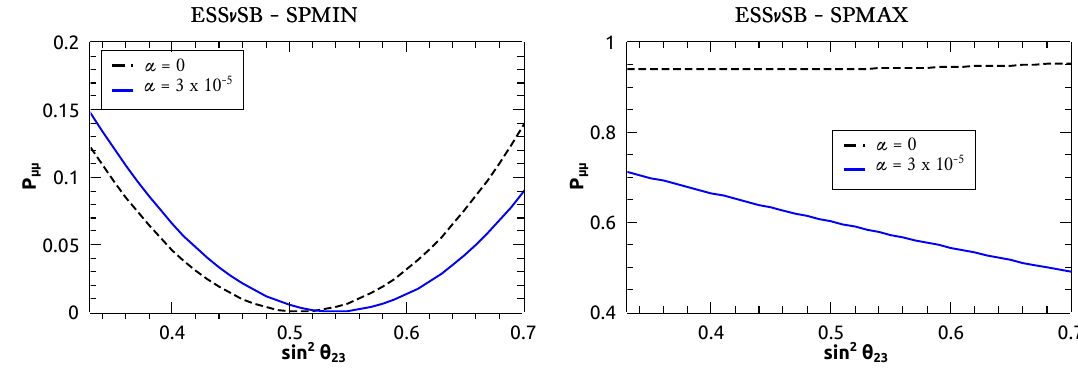
Figure 2 . The probabilities as a function of sin 2 θ 23 at L = 540 km for ESS ν SB. The left (right) panel shows ν µ → ν e ( ν µ → ν µ ) probabilities. The black dashed (blue) curves are for α = 0 and α = 3 × 10 − 5 eV 2